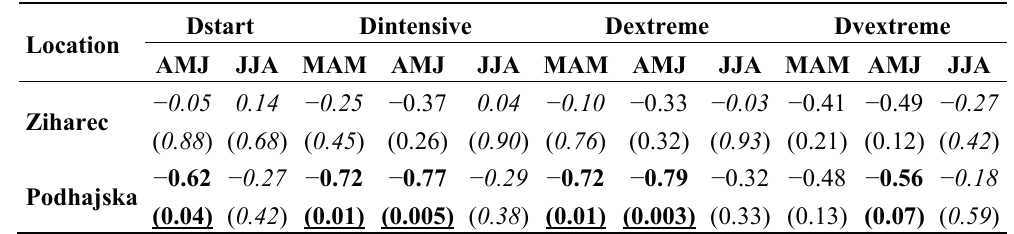
Table 12. Correlation coefficients and p values (in brackets, underlined values are significant) between AMI describing number of dry days and RDSY for MZ relative to observed value. No effect: 10 of 22 ; with effect: 6 of 22 . Dstart Location